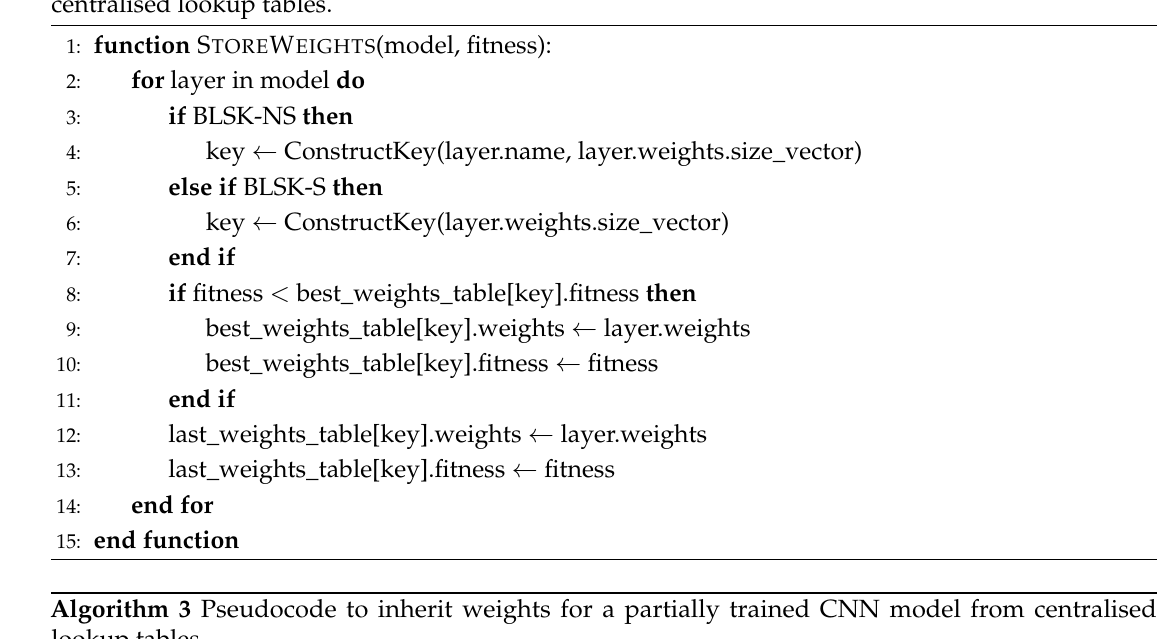
Algorithm 2 Pseudocode to store weights of a partially trained CNN model with fitness value using centralised lookup tables.